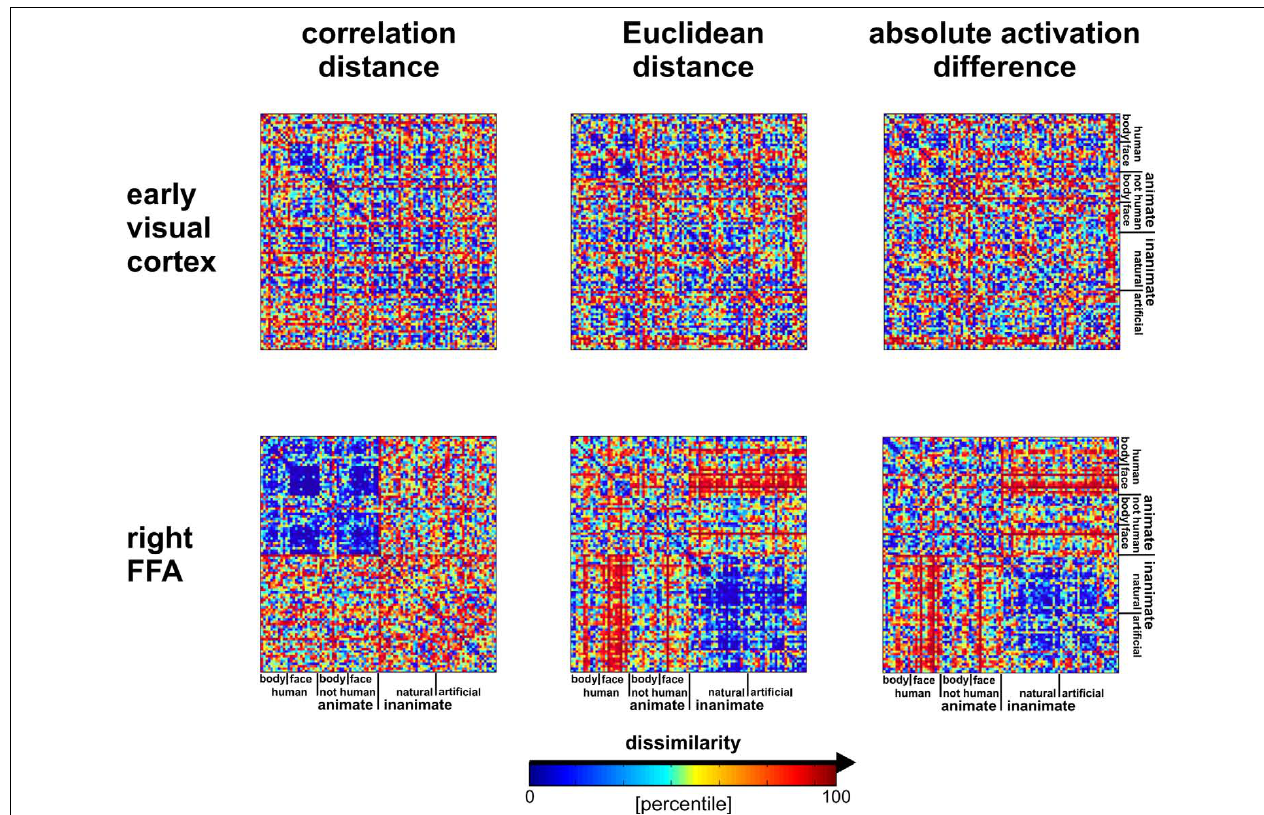
FIGURE 10 | Dissimilarity matrices of activity patterns elicited in early visual cortex and FFA by viewing 96 object images . Dissimilarity matrices (as introduced in Figure 2 ) are shown for early visual cortex (top row) and right FFA (bottom row) and for three different measures of dissimilarity (columns): 1 − correlation (Pearson correlation across space), the Euclidean distance between the two response patterns (in standard error units) and the absolute activation difference (i.e., the absolute value of the difference of the spatial-mean activity level). The absolute activation difference is sensitive only to the overall level of activation and has been included only because regional-average activation is conventionally targeted in fMRI analysis. Note that the correlation